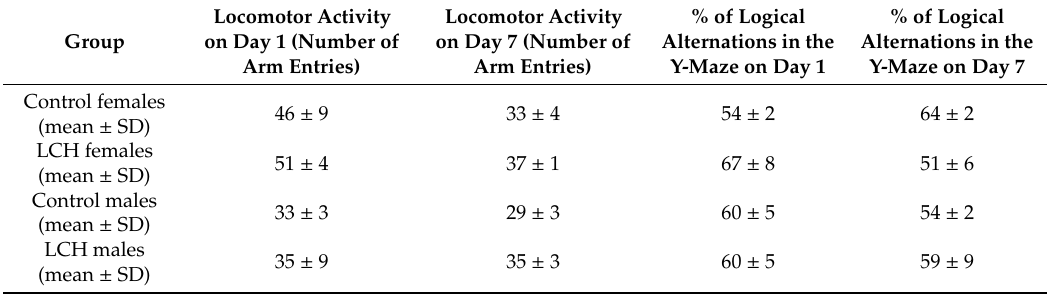
Table 7. Locomotor activity and fresh spatial memory in Y-maze on day 1 and day